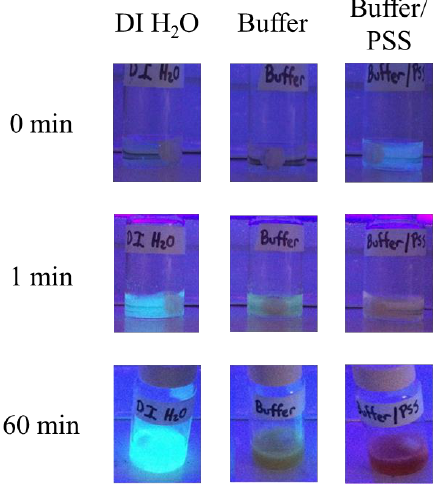
Figure 3. Image of the initial stages of the enzymatic polymerization of indole under 365 nm blacklight in the presence of DI water, citrate buffer, and buffer and PSS. All solutions contain 30% ethanol as